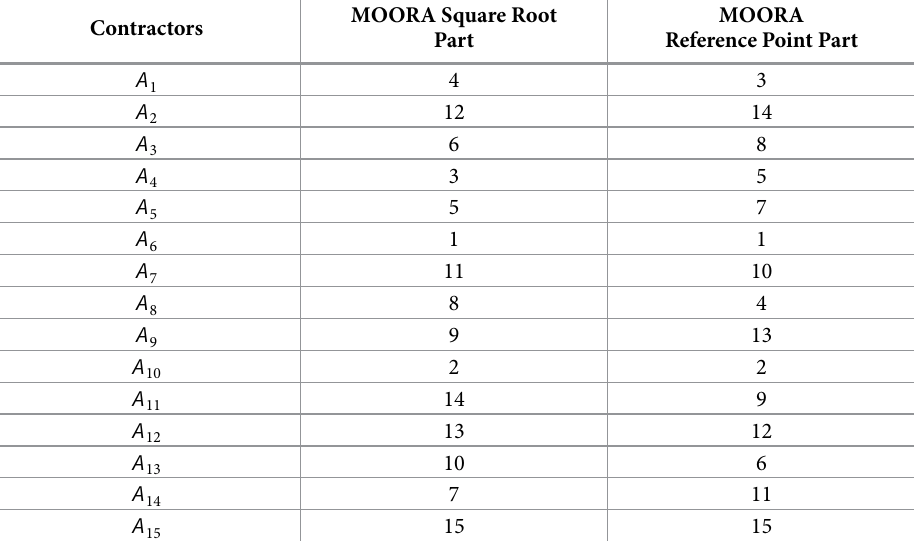
table 3. Ranking of the 15 contractors by the 2 parts of MOORA moora square root moora contractors reference Point Part Part a 1 4